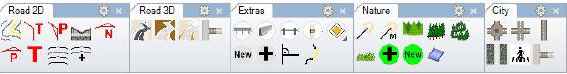
Figure 3. Plug-in functions (interface toolbar).